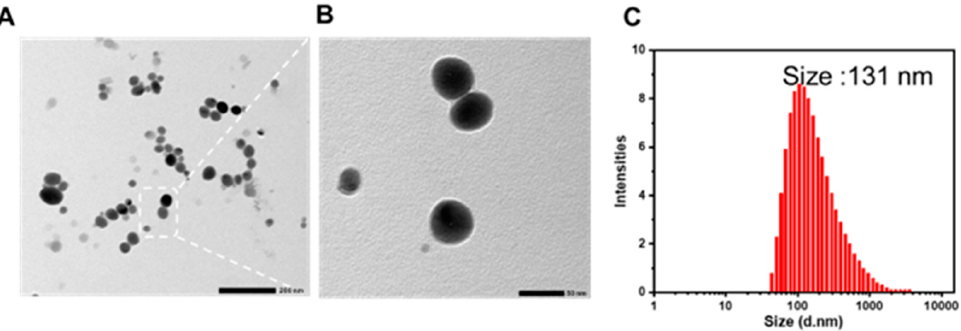
Figure 2. Particle properties of LNT-SeNPs. ( A , B ) TEM images of LNT-SeNPs (bar size = 200 and 50 nm, respectively). ( C ) Dynamic light scattering (DLS) measurement.